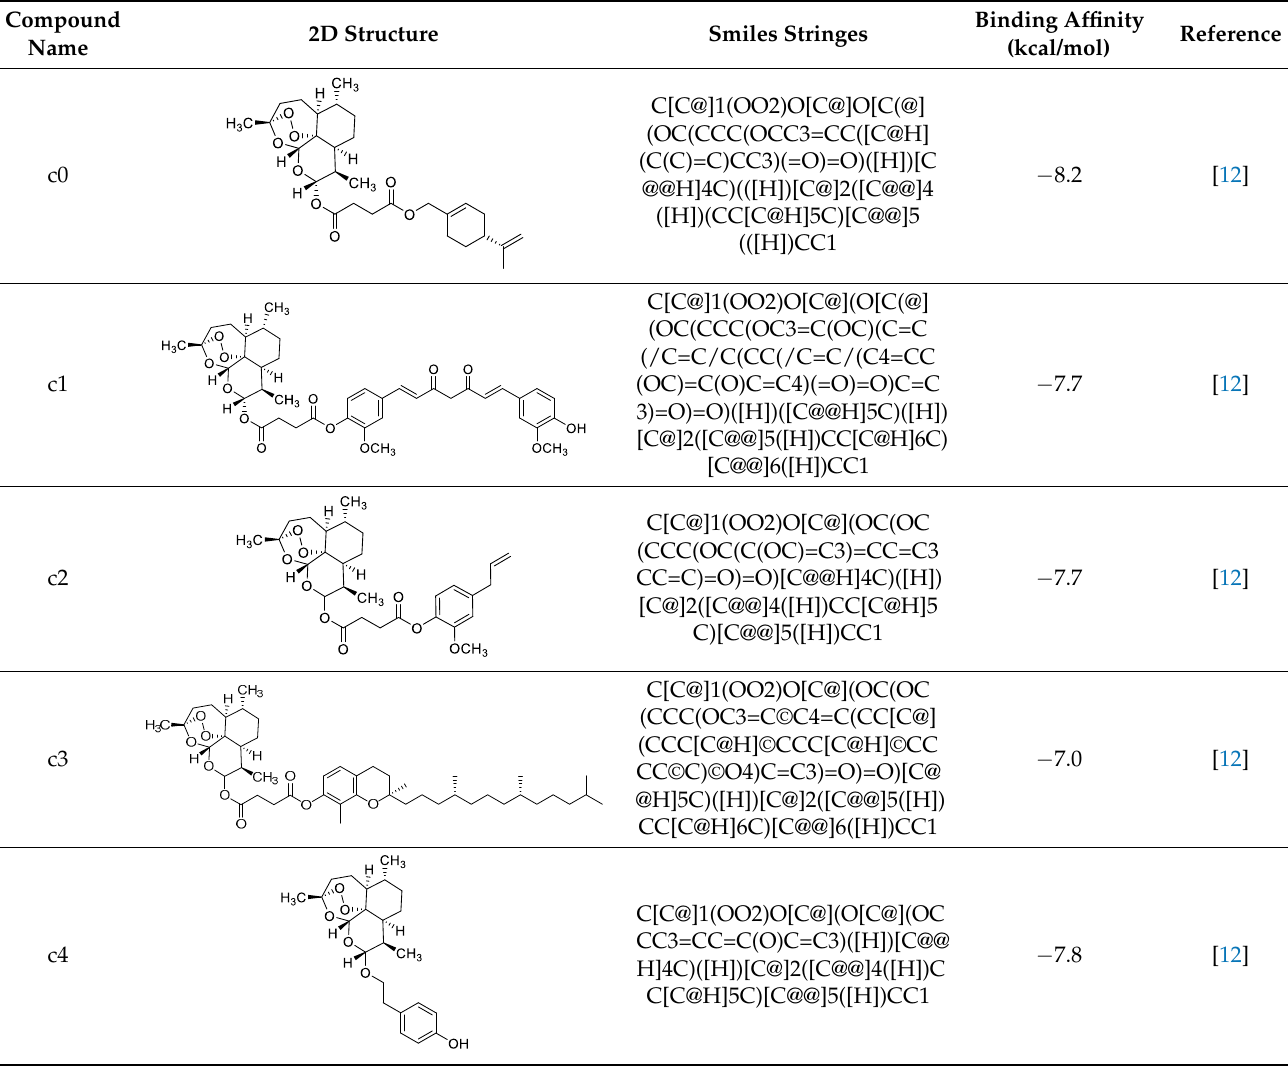
Table 1. Molecular docking results for: (i) each of the new synthetized artemisinin-based derivatives (compounds c0 – c7 ), (ii) the camptothecin (CPT), (iii) other compounds (CPT-derived) considered hTop1p inhibitors. For all the listed compounds the molecular docking simulation was performed with the CPT-deprived 1T8I complex by running the most used software for moleular docking, Autodock Vina.